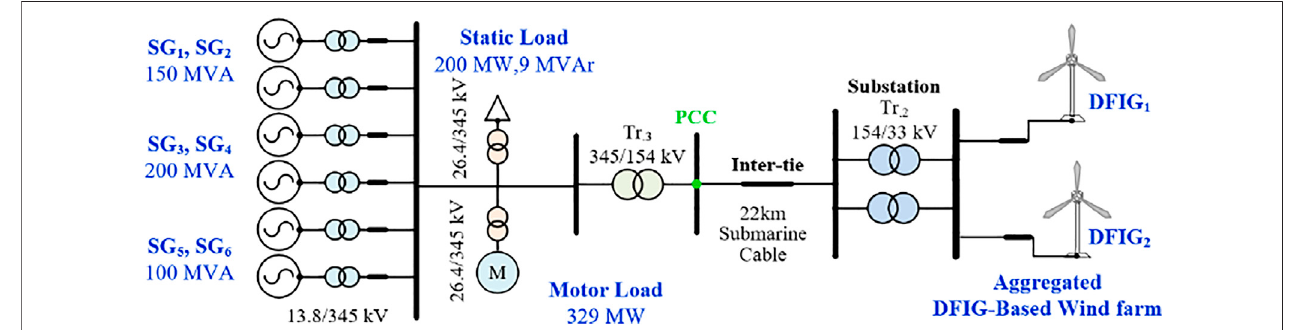
FIGURE 7 | Model system.